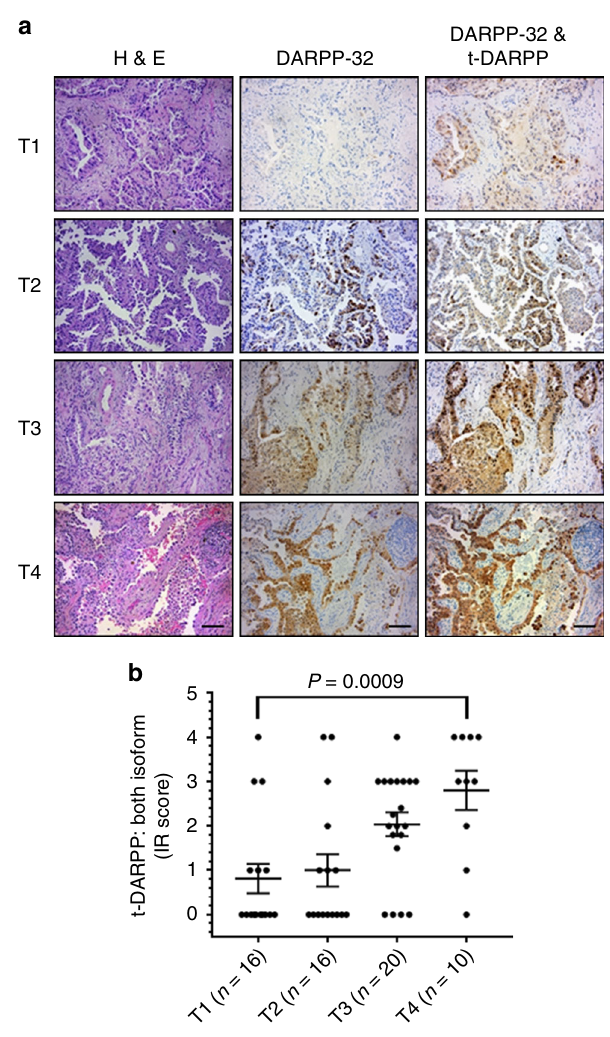
Fig. 7 Elevated t-DARPP protein expression positively correlates with tumor (T) staging score in lung adenocarcinoma patients. a Immunohistochemistry was performed on human NSCLC serially sectioned specimens using an N- terminal DARPP-32 antibody to exclusively detect DARPP-32 and a C- terminal DARPP-32 antibody to detect both DARPP-32 and t-DARPP. Scale bar, 50 µ m. b Differential immunohistochemistry was used to quantify t- DARPP protein expression in 62 human lung cancer tissue samples. Each tissue was scored based on the percentage of tumor cells stained positive multiplied by the staining intensity (i.e., 0 = none, 1 = weak, 2 = moderate, 3 = strong expression) to yield an immune reactive (IR) score. The IR score for t-DARPP protein expression was calculated by subtracting the IR score of DARPP-32 (detected with N-terminal antibody) from the IR score of both DARPP-32 isoforms (detected with C-terminal antibody). Each point on the graph represents an individual tissue. Error bars indicate SEM. The P value has been calculated using one-way ANOVA followed by Dunnett ’ s test for multiple 3-kinase/Akt signaling. DARPP-32 stimulated resistance to pro- apoptotic proteins through induction of pro-survival molecule Bcl-xL through Src/STAT3 (signal transducer and activator of transcription 3) signaling cascades 16 . Numerous reports have implicated t-DARPP in breast cancer patients acquiring resistance to trastuzumab (Herceptin), a monoclonal antibody targeting the ERBB2 (Her2/neu) receptor. Collectively, these studies demonstrated that t-DARPP drives breast cancer cell resistance to trastuzumab through inhibition of apoptotic